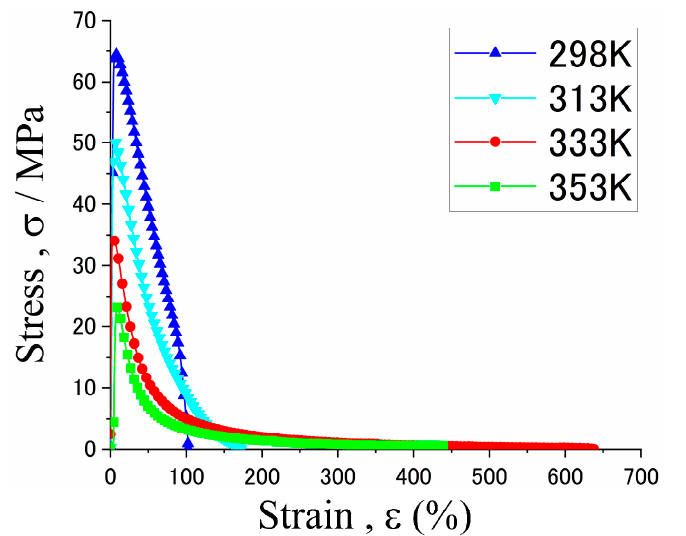
Figure 10. Stress–strain curves of Sn-40Bi-0.1Zn under a strain rate of 5.25 × 10 − 4 s − 1 at various tem- peratures.